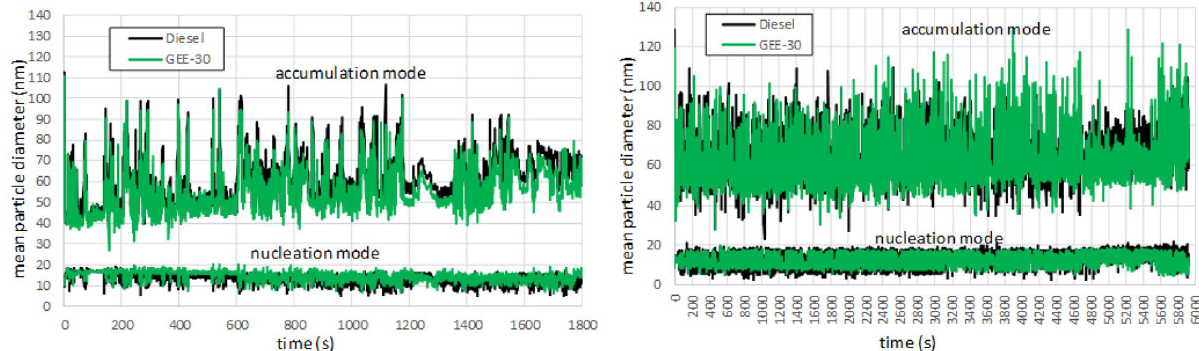
Figure 12. Mean particle diameters along WLTC (left) and along RDE